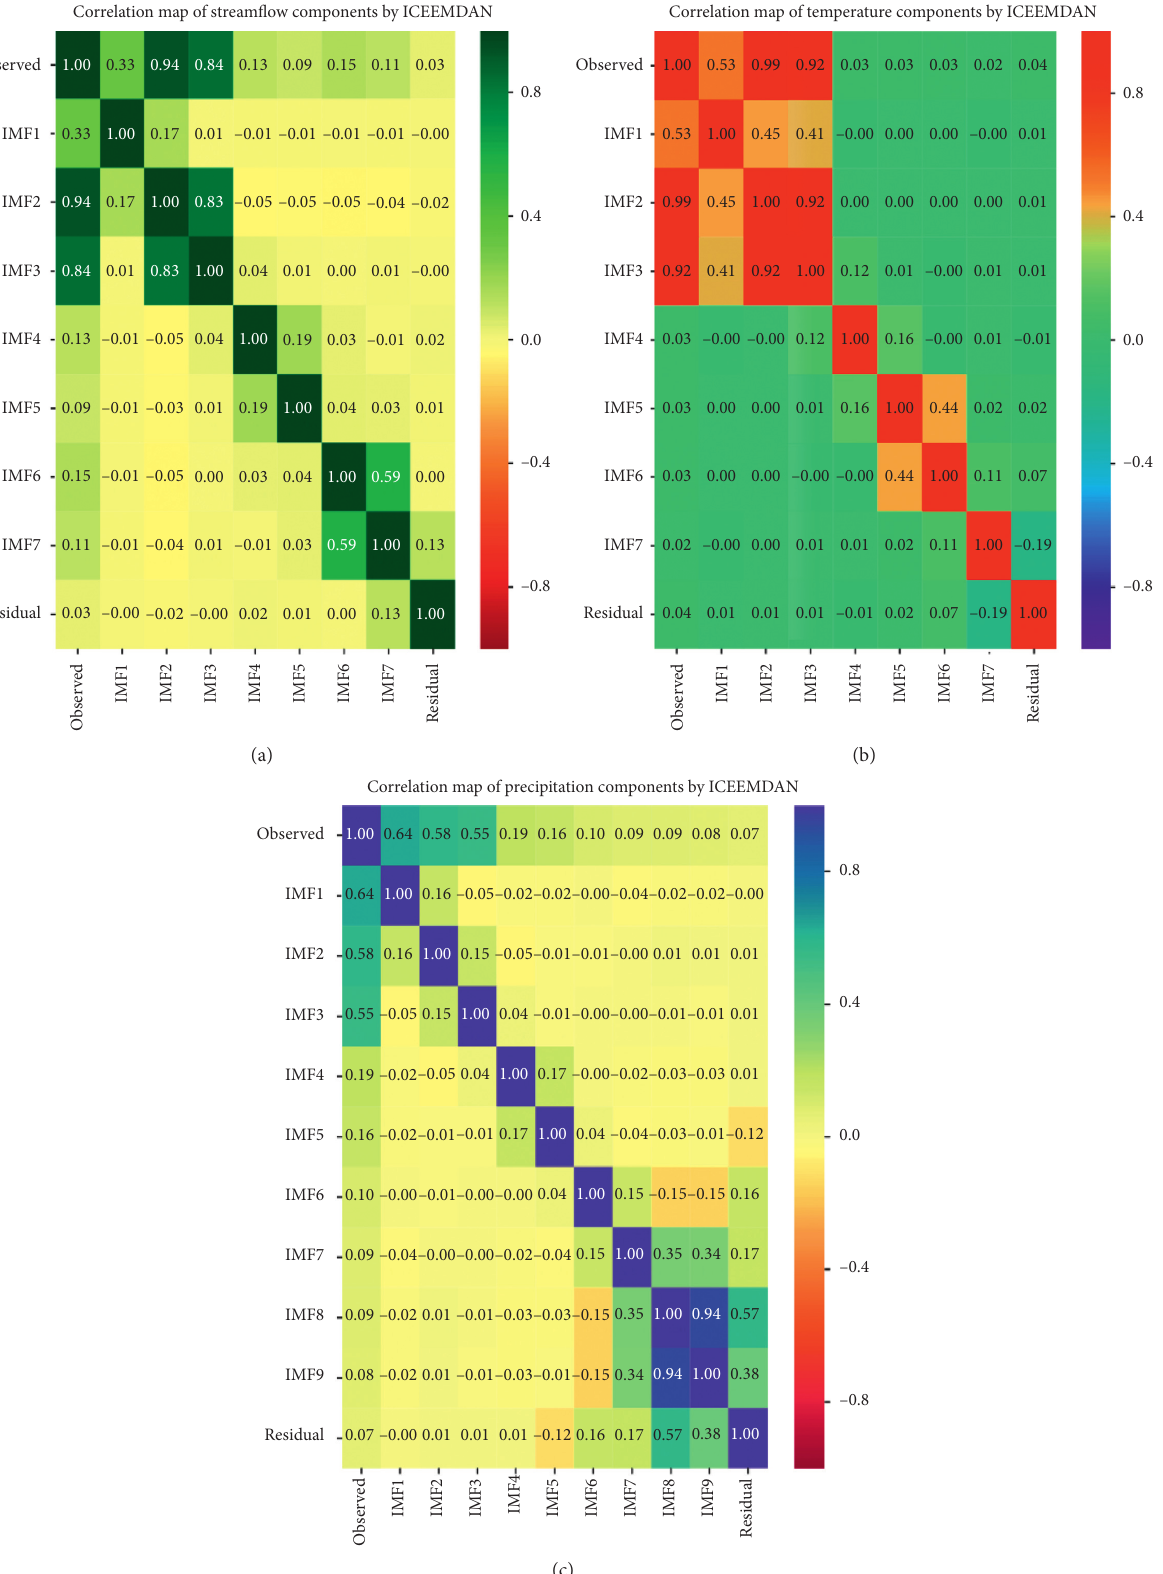
Figure 5: Maps presenting the correlation between the observed time series and the decomposed components obtained after ICEEMDAN. (a) Streamflow. (b) Temperature. (c)